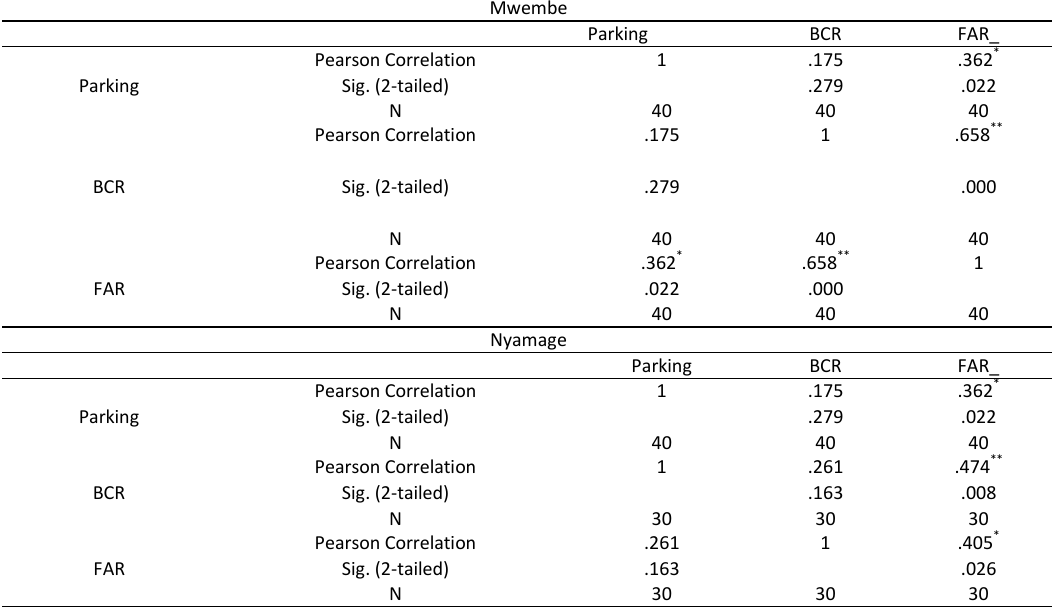
Table 6: Correlation matrix for BCR, FAR and parking, Mwembe and Nyamage